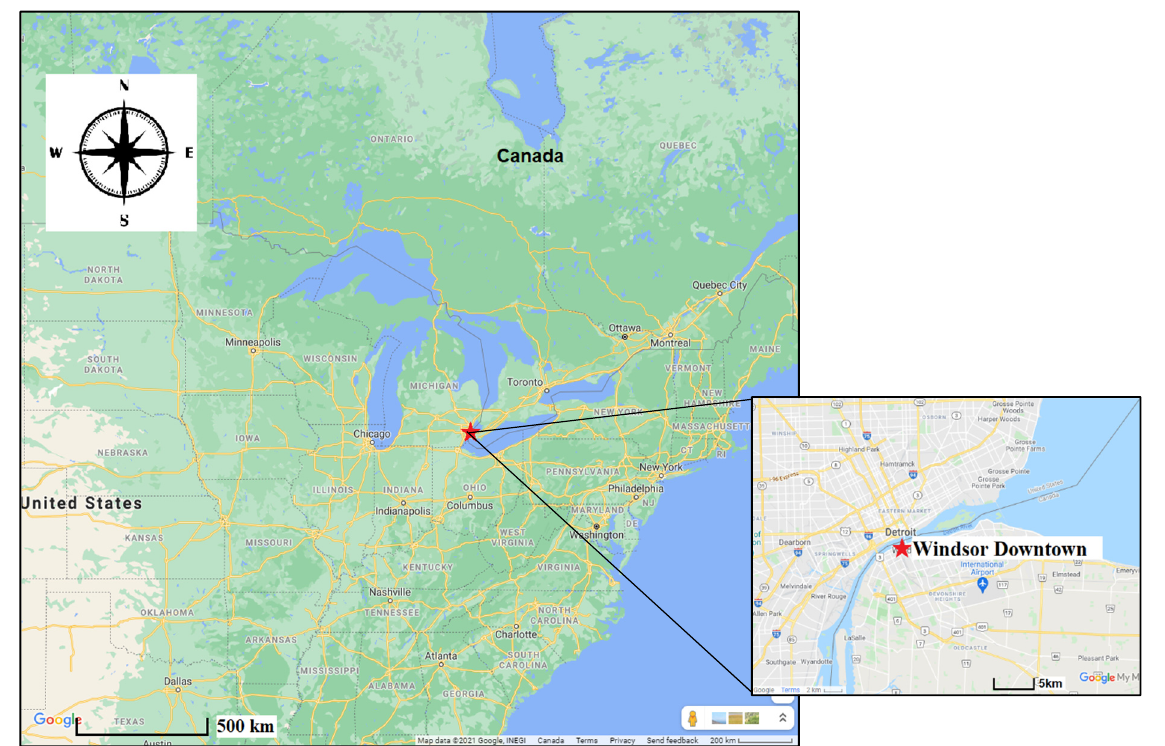
Figure 1. Windsor Downtown AQHI monitoring station (red star) in Windsor, Ontario (base maps adapted from Google Maps, coordinates of the station from MECP [4]).